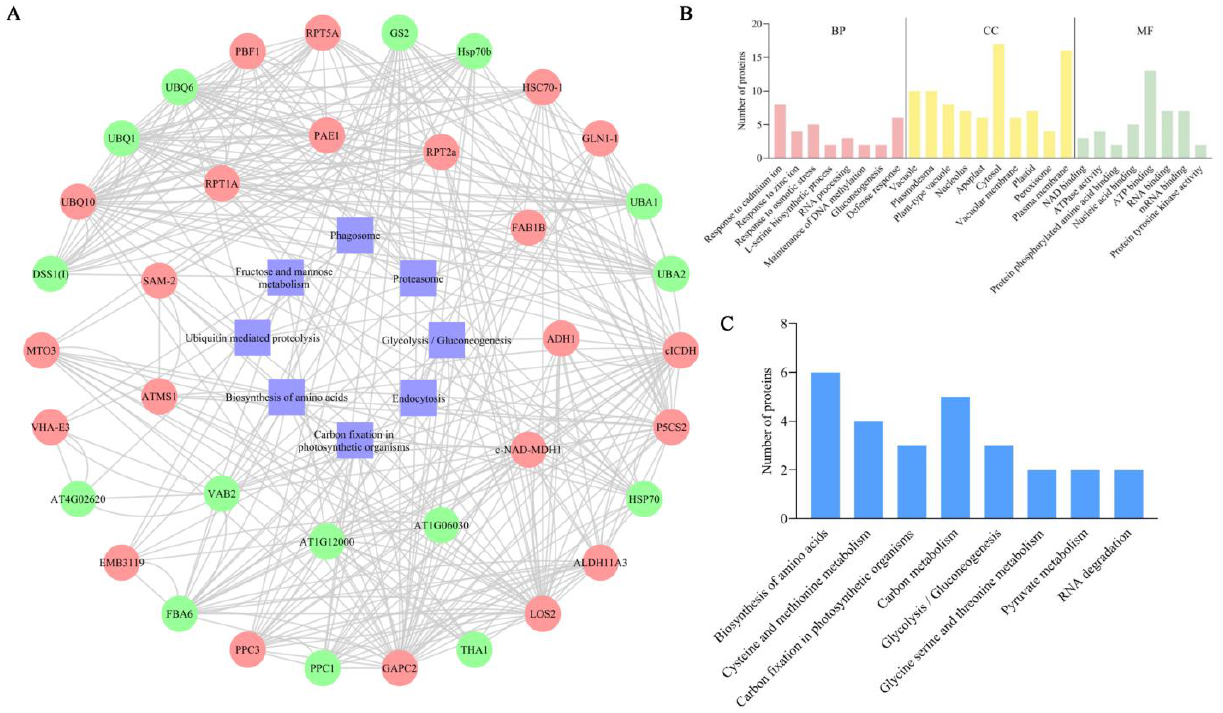
Figure 5. Interacting protein map of the DEUPs and phosphorylation site analysis of key DEUPs. ( A ) Predicted map of the DEUP interactions. ( B ) GO functional annotation of ubiquitinated and phosphorylated co-modified proteins. ( C ) KEGG functional annotation of the ubiquitinated and phosphorylated co-modified proteins.